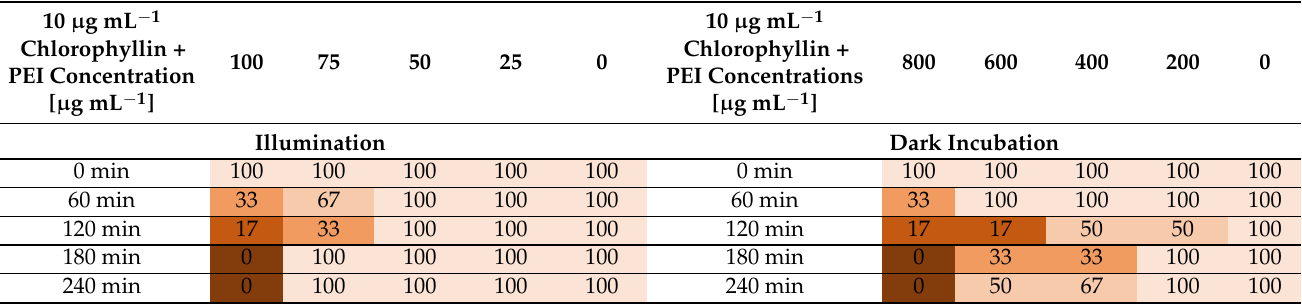
Table 1. Effect of different concentrations of PEI (0, 25, 50, 75, and 100 µ g mL − 1 under light conditions and (0, 200, 400, 600, 800 100 µ g mL − 1 under dark conditions, respectively) and 10 µ g mL − 1 chloro- phyllin on the viability of E. coli RB791 upon illumination with a blue-red light source (12.7 mW cm − 2 ) and in darkness at 0 min, 60 min, 120 min, 180 min, and 240 min of incubation. No growth was considered as 0%, growth reduction as 33% (strong) and 66% (moderate), and average growth as 100%. The eradication percentages are presented as the average of three independent experiments. The darker the colors, the higher the